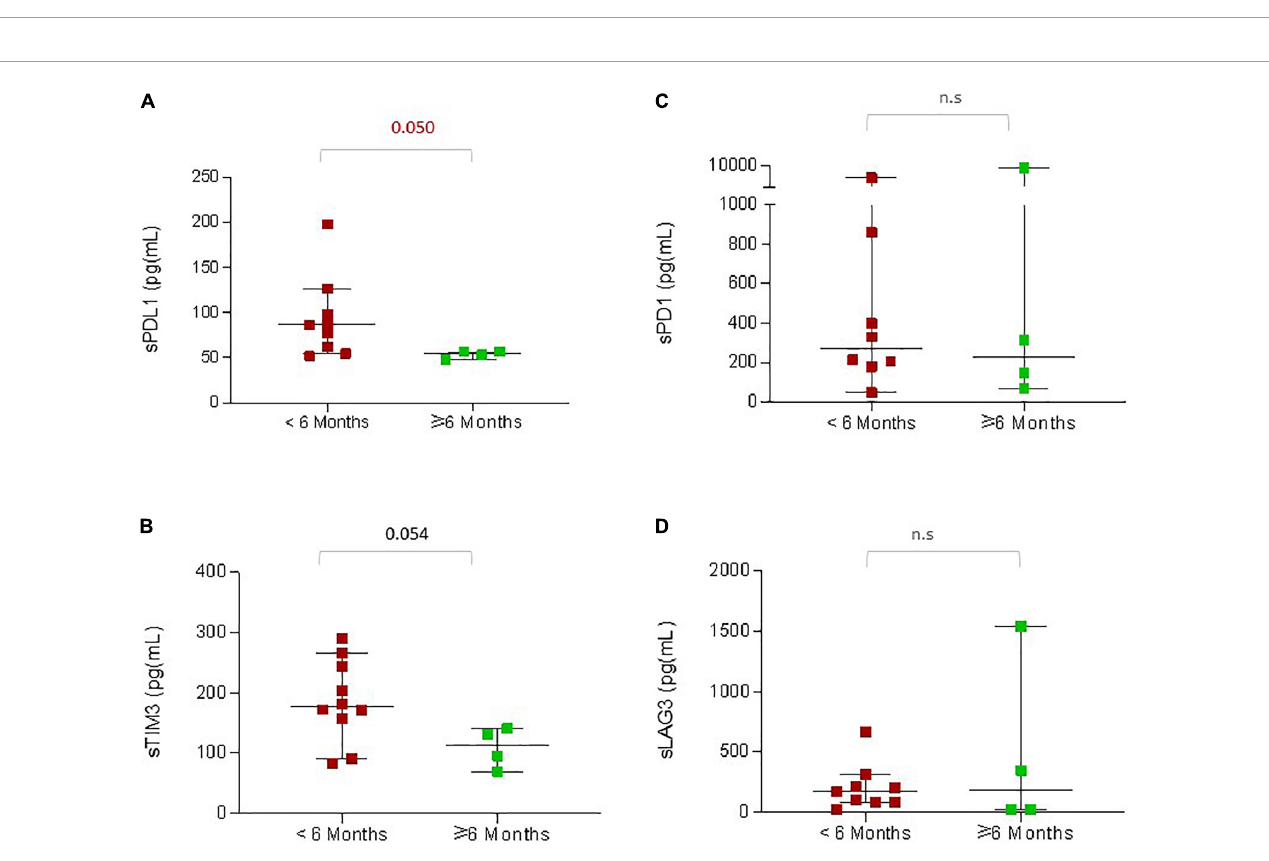
FIGURE3 sICPs in younger patients associated with reduced PFS. The graphs indicate pre-treatment concentrations of the soluble immune checkpoint proteins according to the PFS: (A) sPDL1, (B) sTIM3, (C) sPD1, (D) sLAG3. The red dots indicate the concentrations of proteins in patients with PFS less than 6 months, and the green dots indicate the concentrations of proteins in patients with PFS greater than 6 months. The P -values are presented above the respective